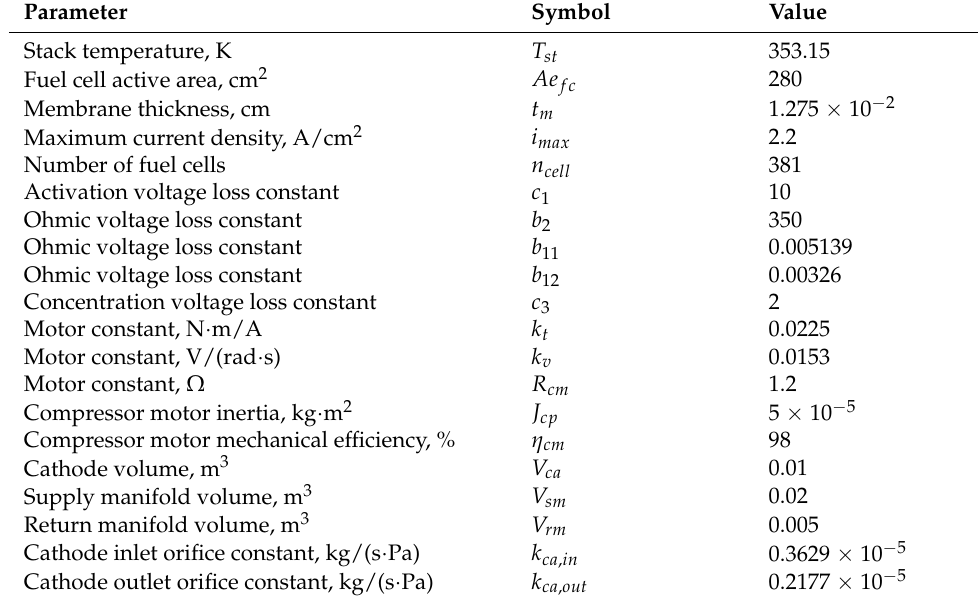
Table 2. PEMFC parameters used in simulation